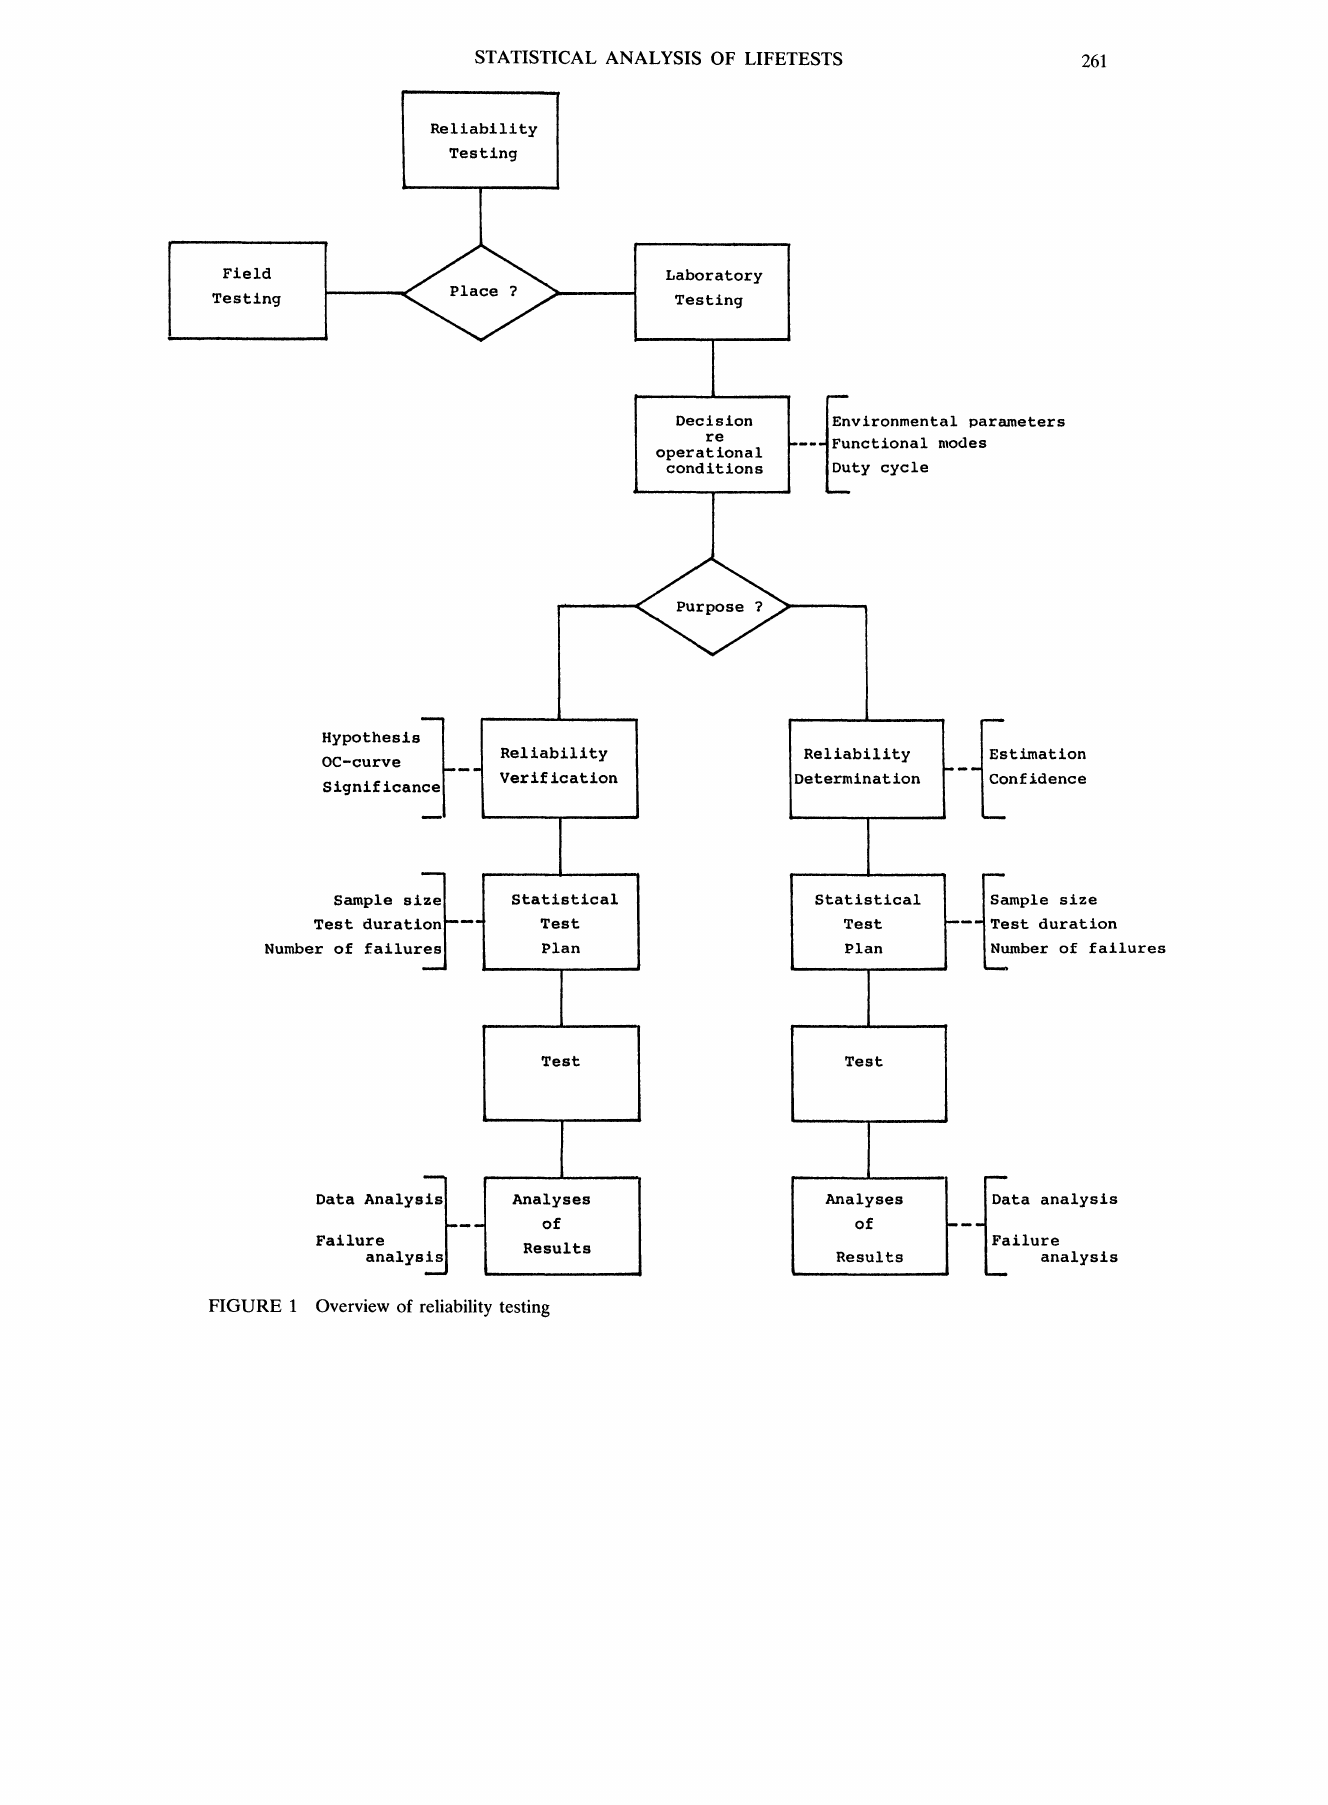
Overview of reliability